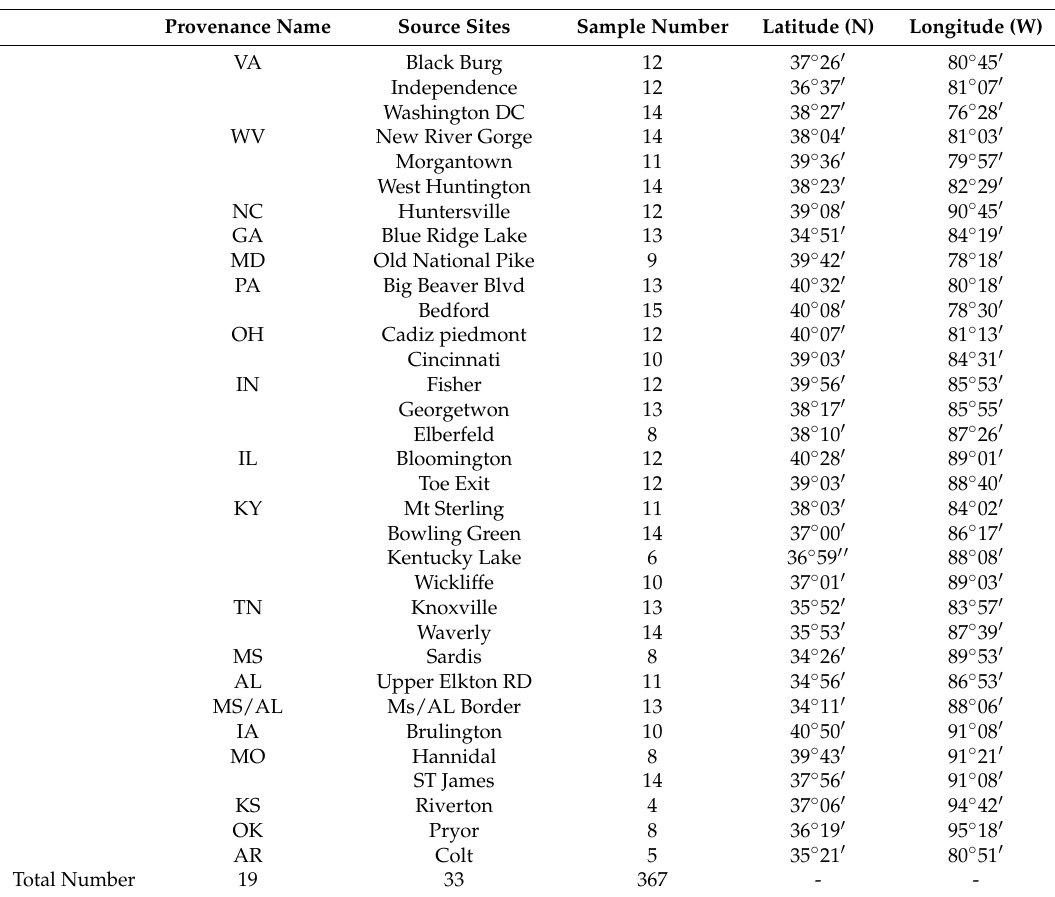
Table 5. Geographic coordinates of the original US locations and numbers of Robinia pseudoacacia L. samples collected from each